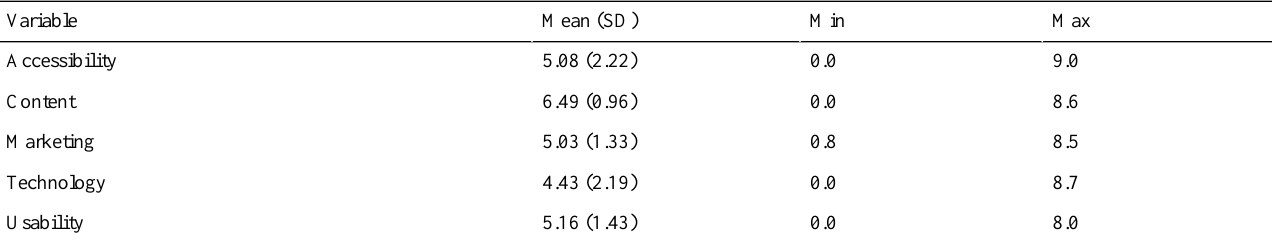
Table 2. Summary statistics for scales